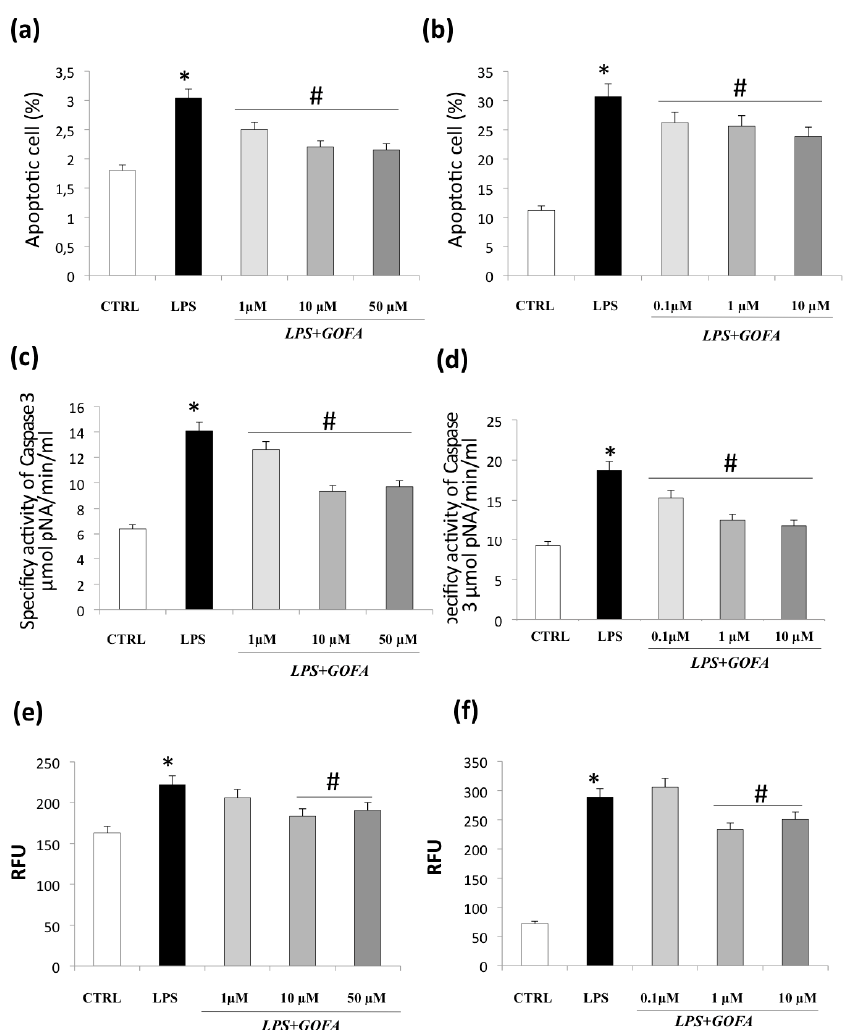
Figure 5. GOFA e ff ects on apoptosis and cell senescence. The e ff ect of GOFA on apoptosis of U937 ( a ) and HCT116 ( b ) cells. The cells were treated with indicated concentration of GOFA for 1 h and then exposed to LPS for 24 h. An Annexin V assay was used for apoptosis detection. ( c ) Bar diagram showing specific e ff ect of GOFA on caspase 3 fluorescent activity on LPS-treated U937 and ( d ) HCT116 cells; ( e ) evaluation of cellular senescence e ff ects of GOFA on U937 and ( f ) HCT116 cells. Cellular senescence was measured using the cellular senescence assay, in which the SA- β -Gal activity was normalized to total protein concentration. All values represent the mean ± SD of three independent experiments. * p < 0.05 vs control cells; # p < 0.05 vs cell treated with LPS alone.